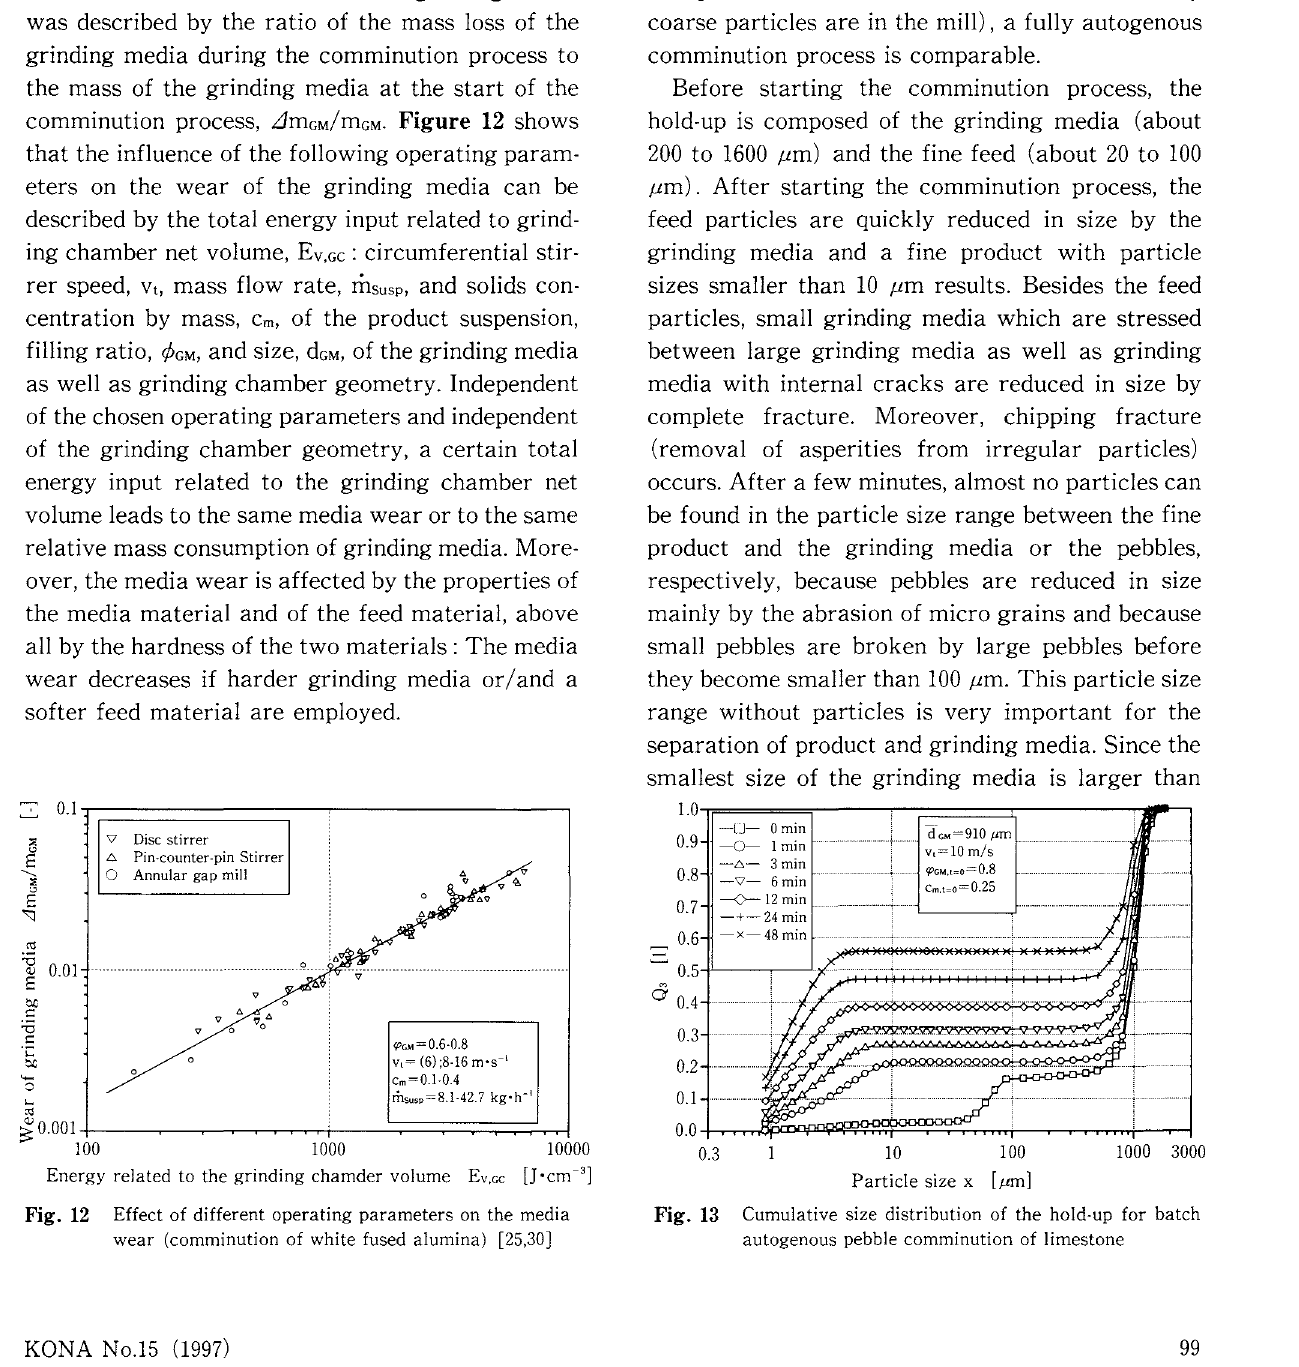
Fig. 13 Cumulative size distribution of the hold-up for batch autogenous pebble comminution of